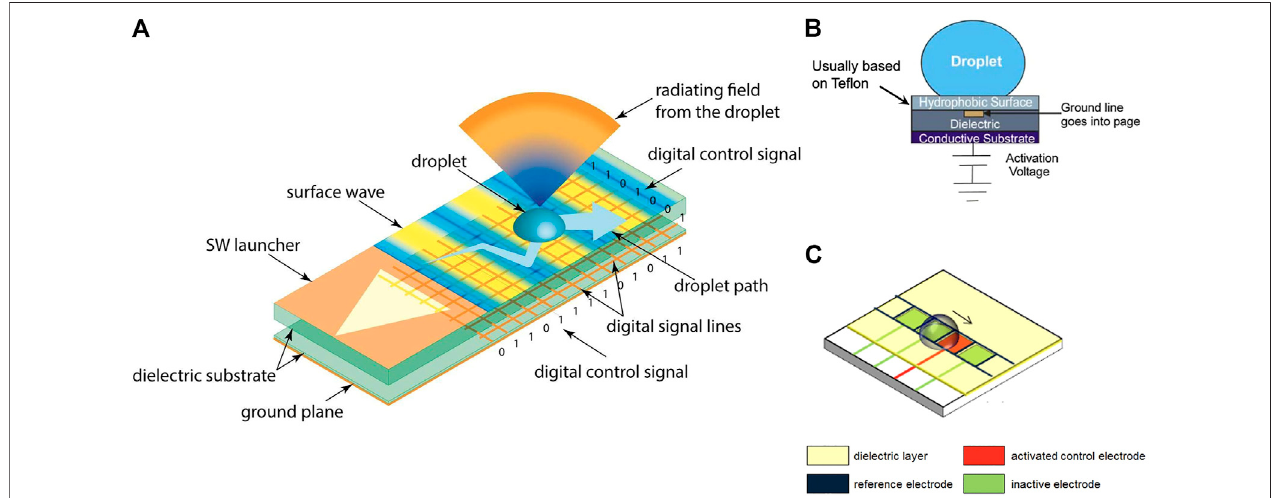
FIGURE 14 | A 2D recon fi gurable radiating surface of a rectangular grid of pixels connected by RF MEMS switches. The components are not drawn to scale.